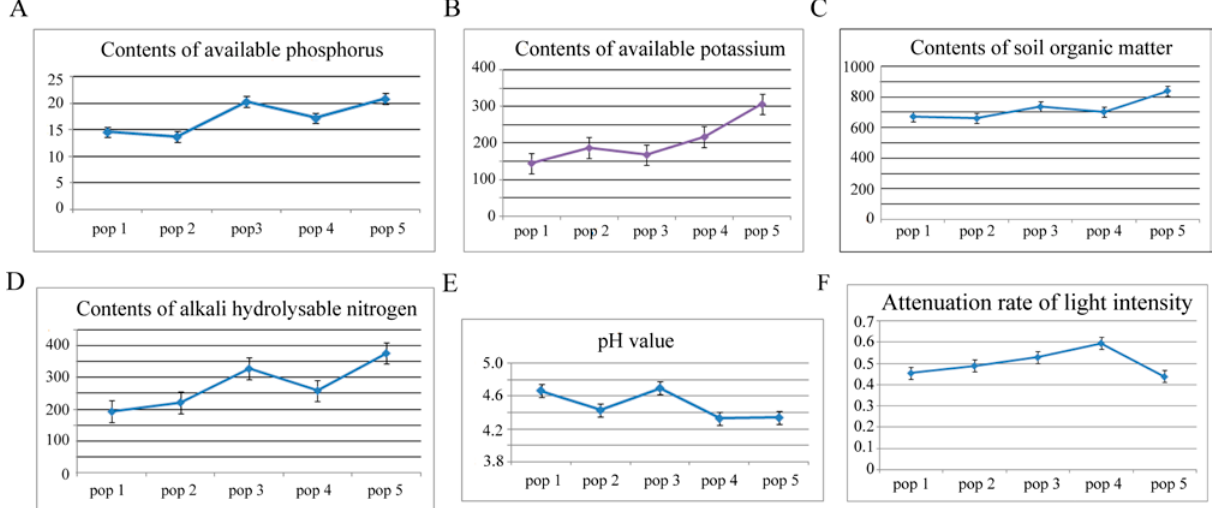
Fig. 2. Contents of aAvailable phosphorus content (A), available potassium content (B), soil organic matter content (C), alkali hydrolys- able nitrogen content (D), soil acidity (E), and attenuation rate of light intensity (F) of five R. simsii populations. Values were represented as mean value ± standard deviation.